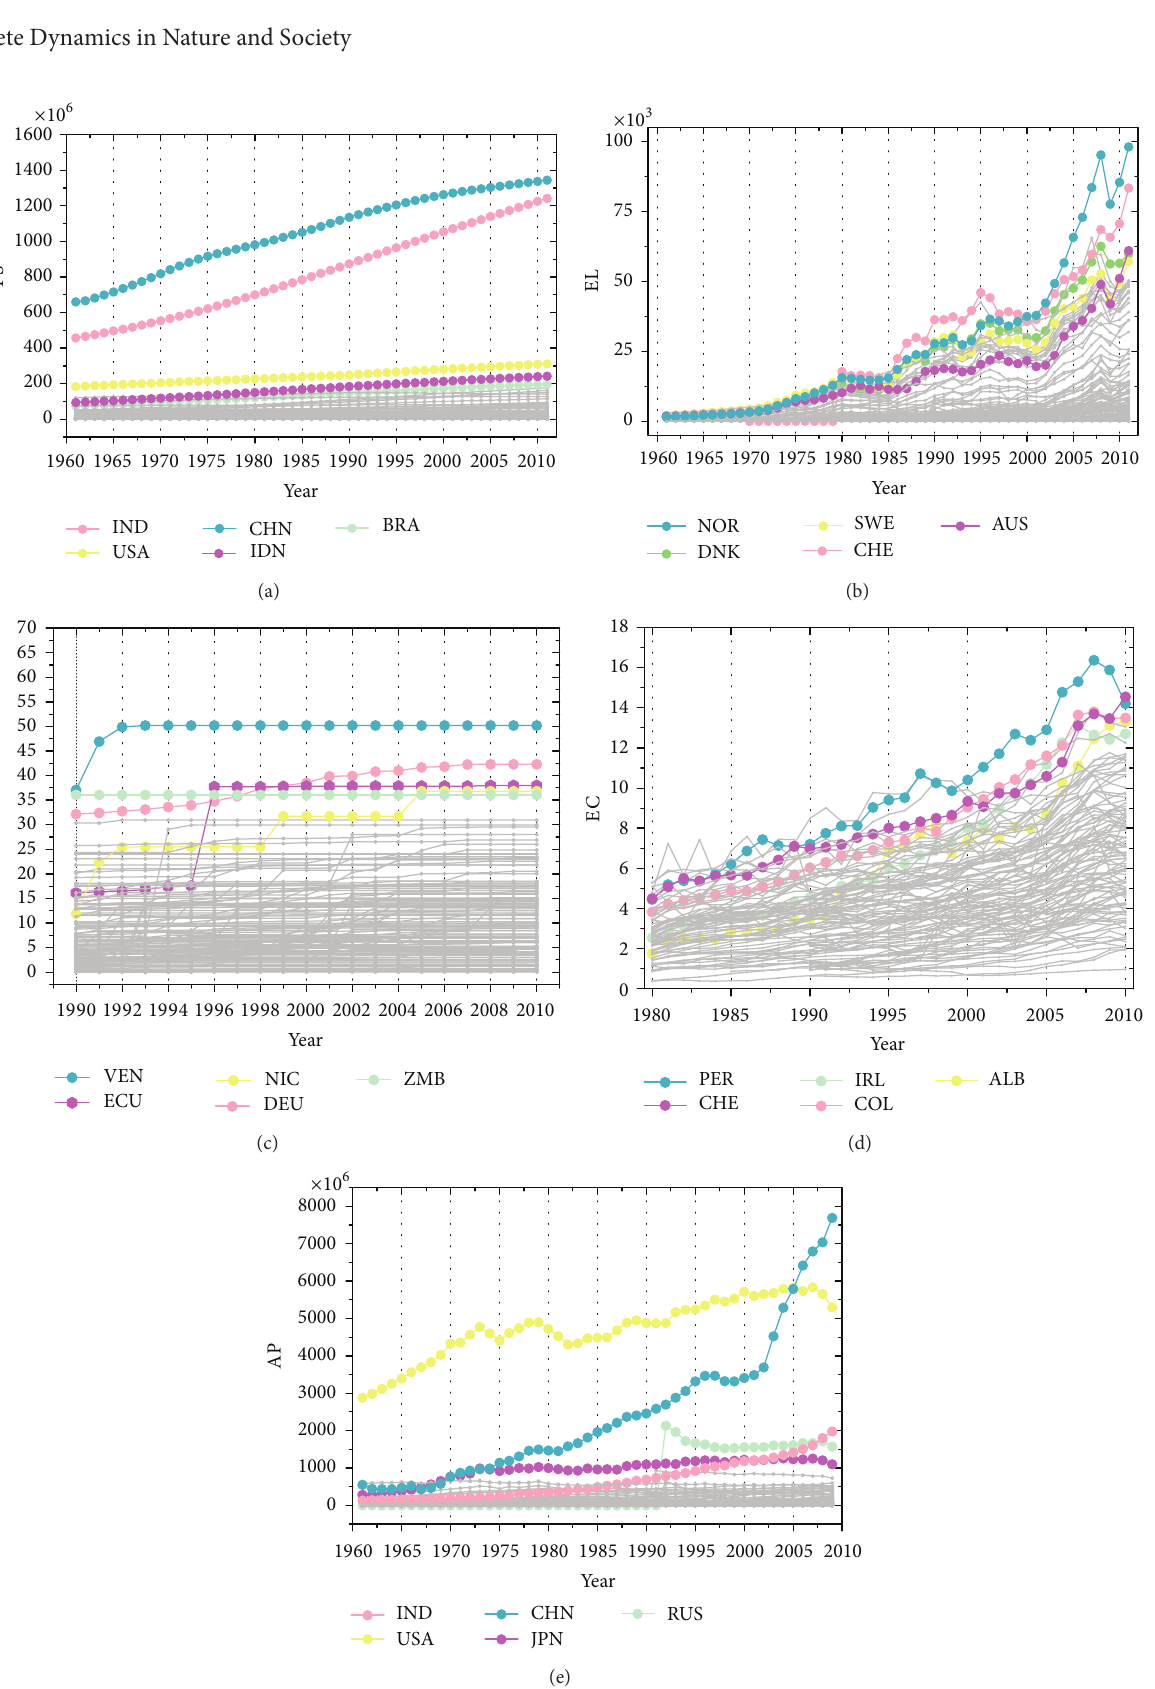
Figure 3: Five factors of evolution of all nodes versus time. (a) Population; (b) economic level; (c) habitats area; (d) energy consumption per GDP; (e) air pollution. In each subgraph, five nations with top amount of corresponding property are